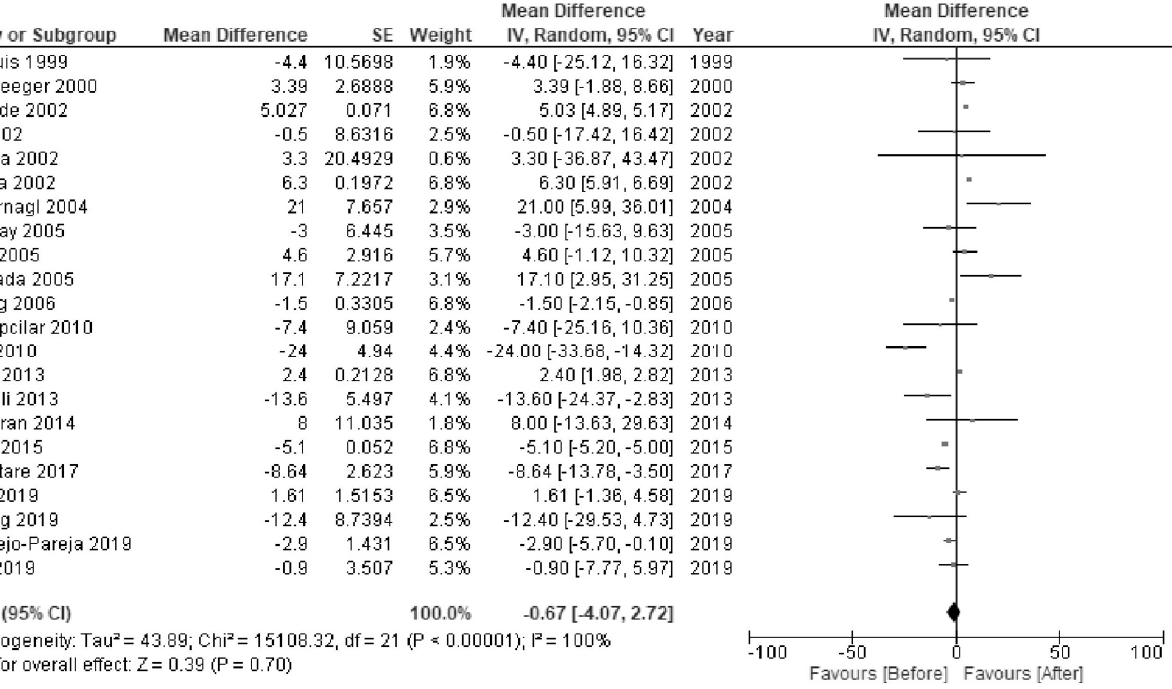
Figure 5. Forest plot of the mean changes in total cholesterol levels before and after Helicobacter pylori eradication.